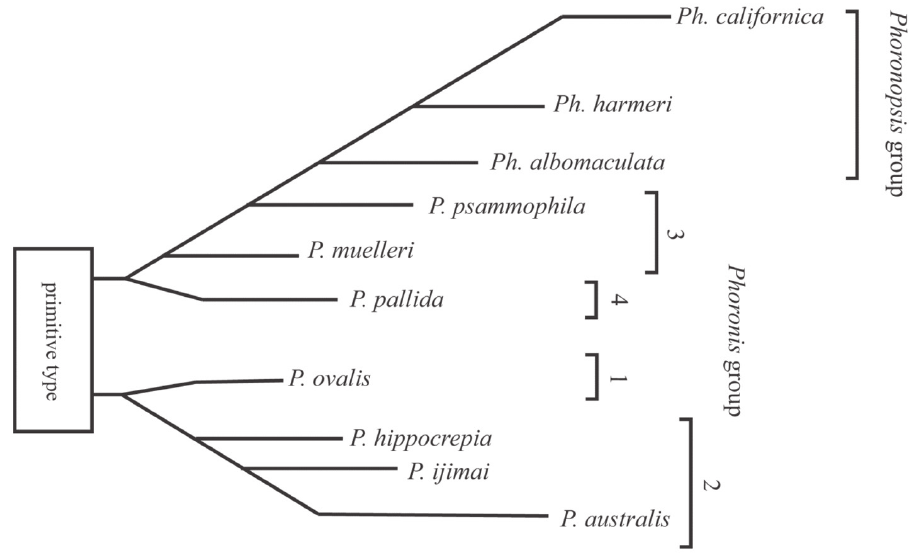
Supplementary Figure S5. Emig’s (1974) classification of five morphological categories within Phoronida, based on nephridial structure. Modified from Emig